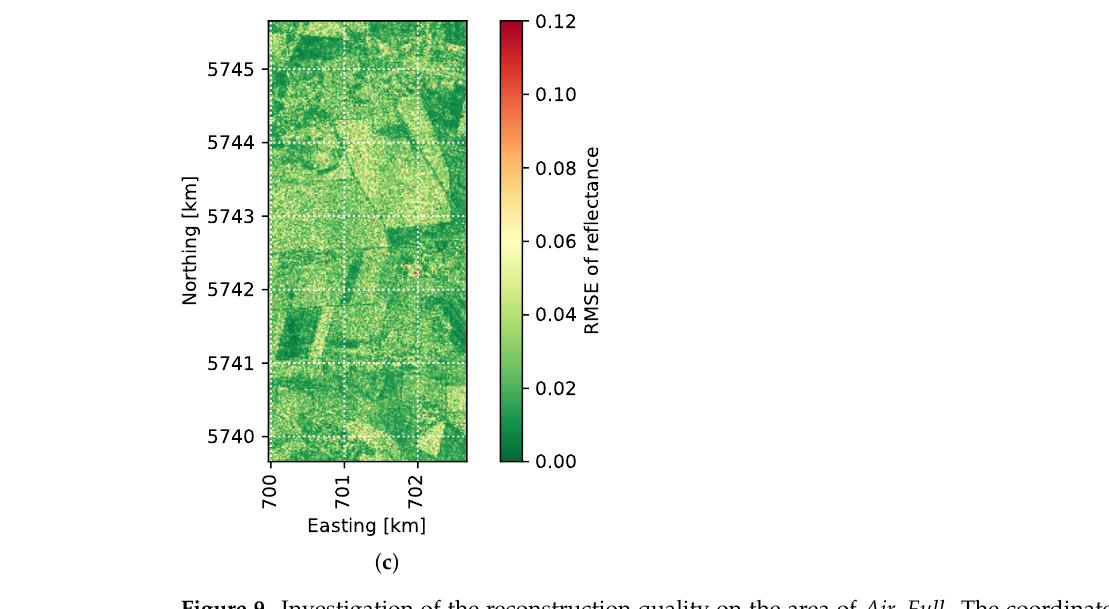
Figure 9. Investigation of the reconstruction quality on the area of Air_Full . The coordinates are in UTM zone 32U. ( a ) Map with normal coloring (see [2]). ( b ) Resulting RMSE with KSVD-BBS . ( c ) Resulting RMSE with DCS-GM